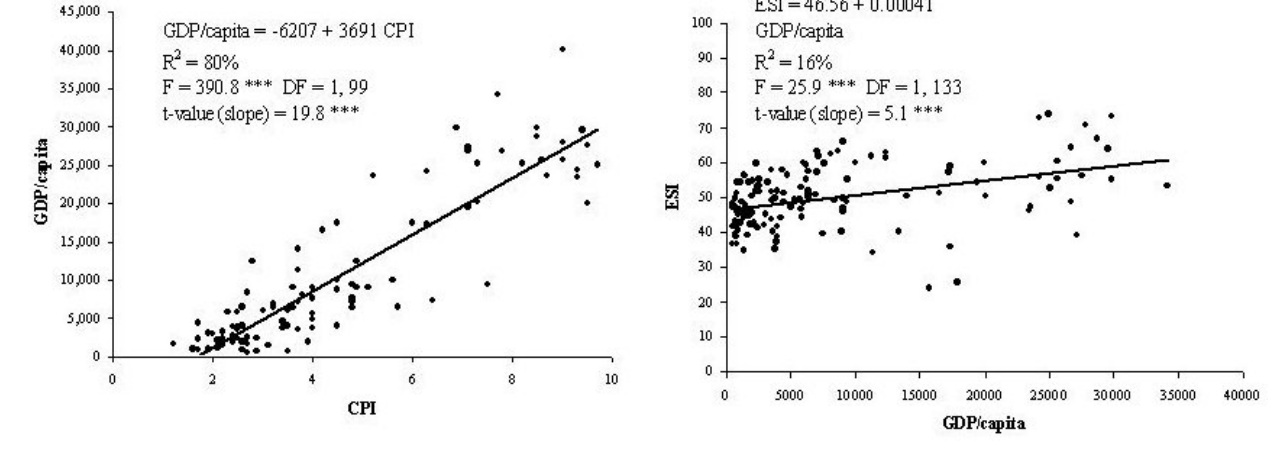
Fig. 1. GDP per capita 2000 (adjusted for PPP) as a function of the Corruption Perception Index (CPI) for 2002, and Environmental Sustainability Index (ESI) for 2002 as a function of GDP per capita 2000 (adjusted for PPP). CPI: scale from 0 (most corrupt) to 10 (least corrupt). ESI: scale from 0 (least sustainable) to 100 (most